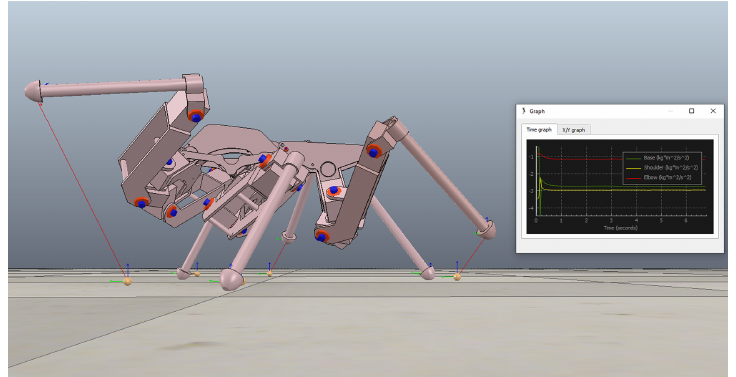
Figure 8. CoppeliaSim simulation of ALPHA in the worst case position during tripod swing phase. The model is simplified to lower the simulation’s computational requirements, while the components’ mass and size are set to that of the topology optimized design (Figure 7).